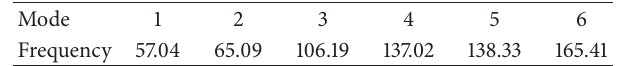
Table 6: Natural frequencies of the frame after modification